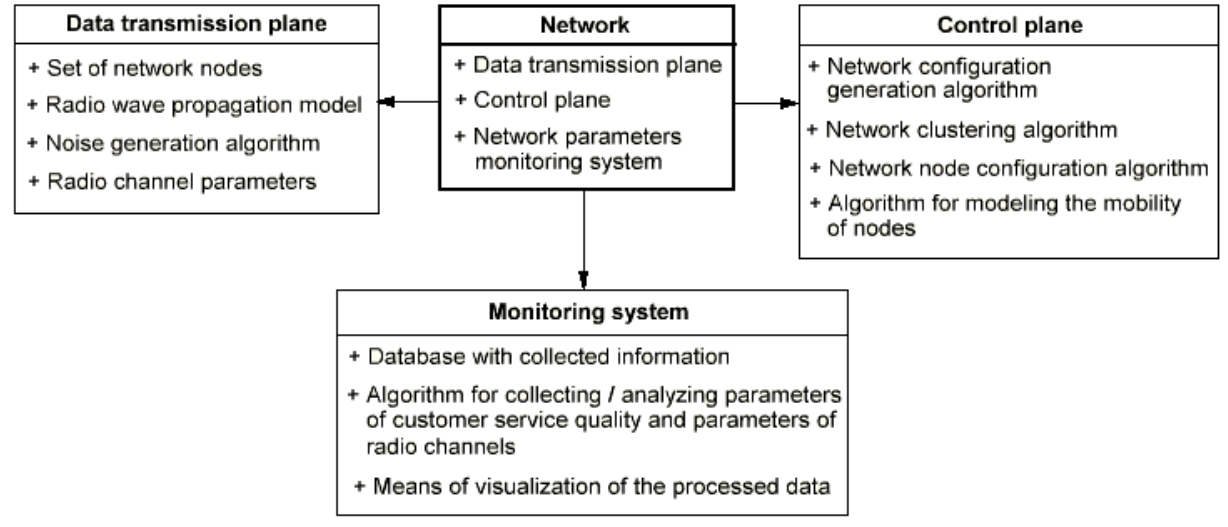
Figure 5. Unified Modeling Language ( UML) diagram of the developed simulator.